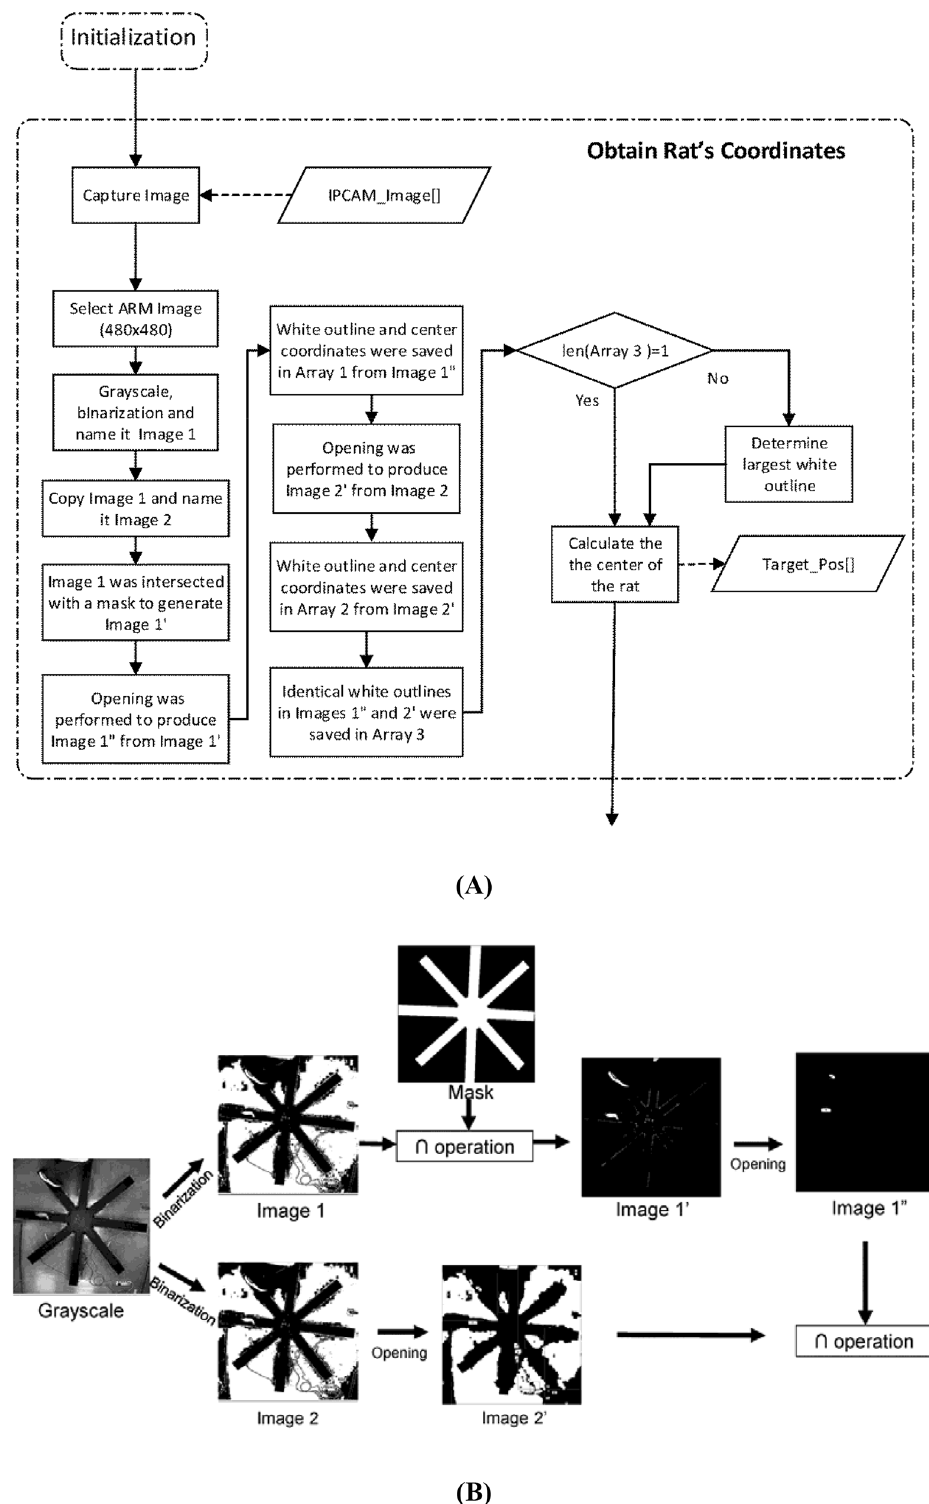
Figure 6. ( A ) Position tracking procedure for rats, ( B ) removal of noise spots caused by an experimenter crossing an arm, and ( C ) by the experimenter whose body covered part of the